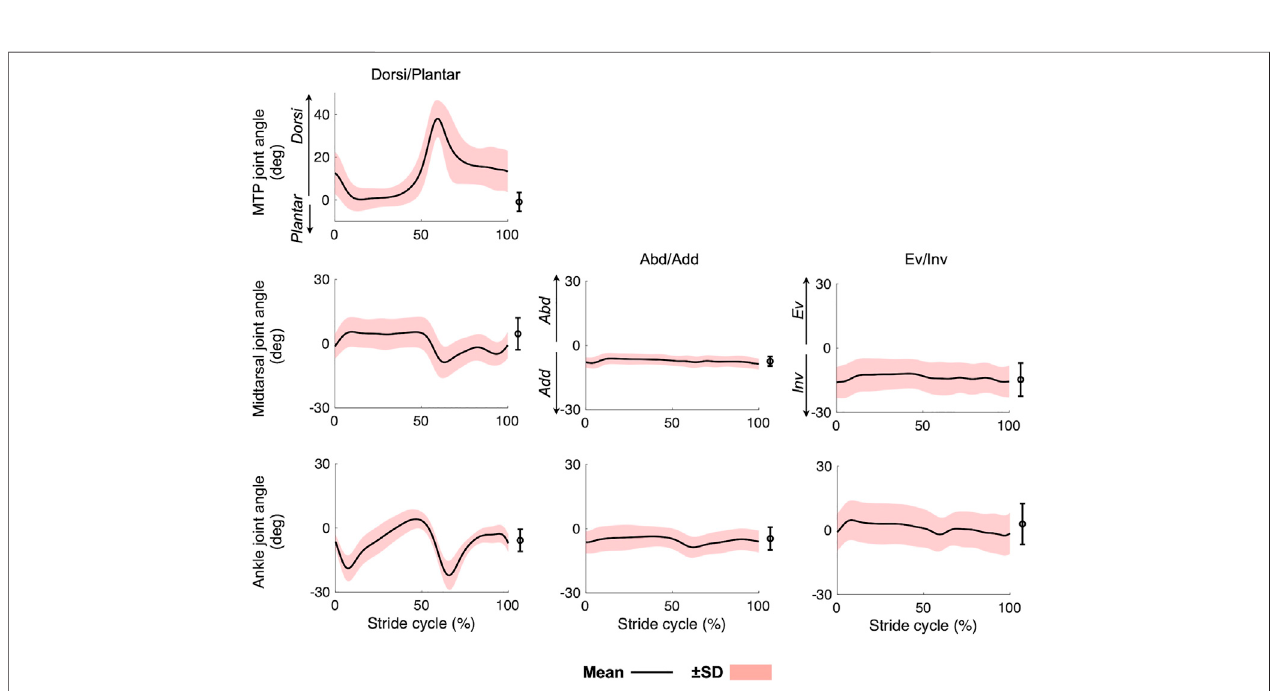
FIGURE3| Mean jointangle pro fi les ofthefoot during walking. Mean(solidline) ±standard deviation (red band). Means and standard deviations ofthe jointangles during quiet standing were also plotted on the right side of each graph.